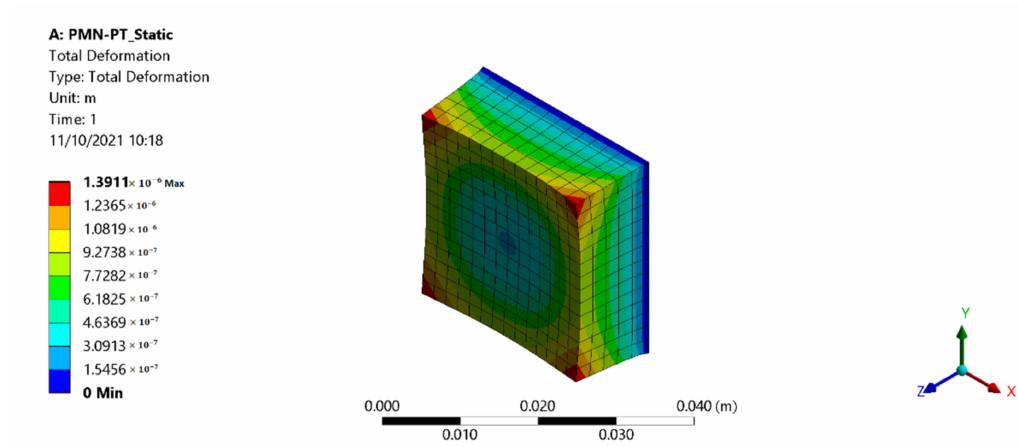
Figure 4. PMN-28% PT plate static analysis result using Method